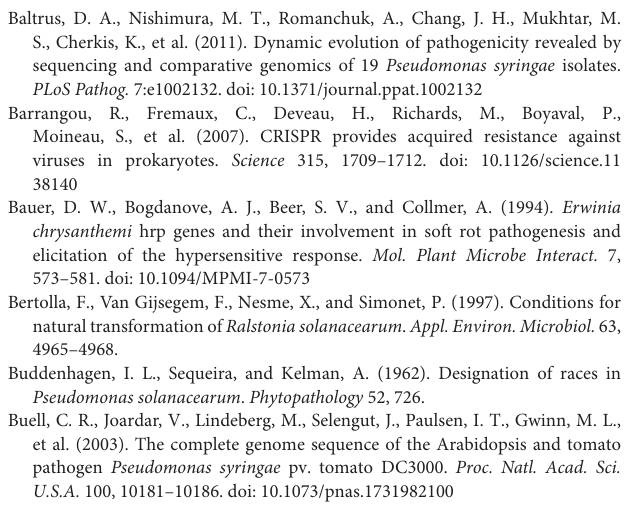
Table S1 | Functional categories based on COG in